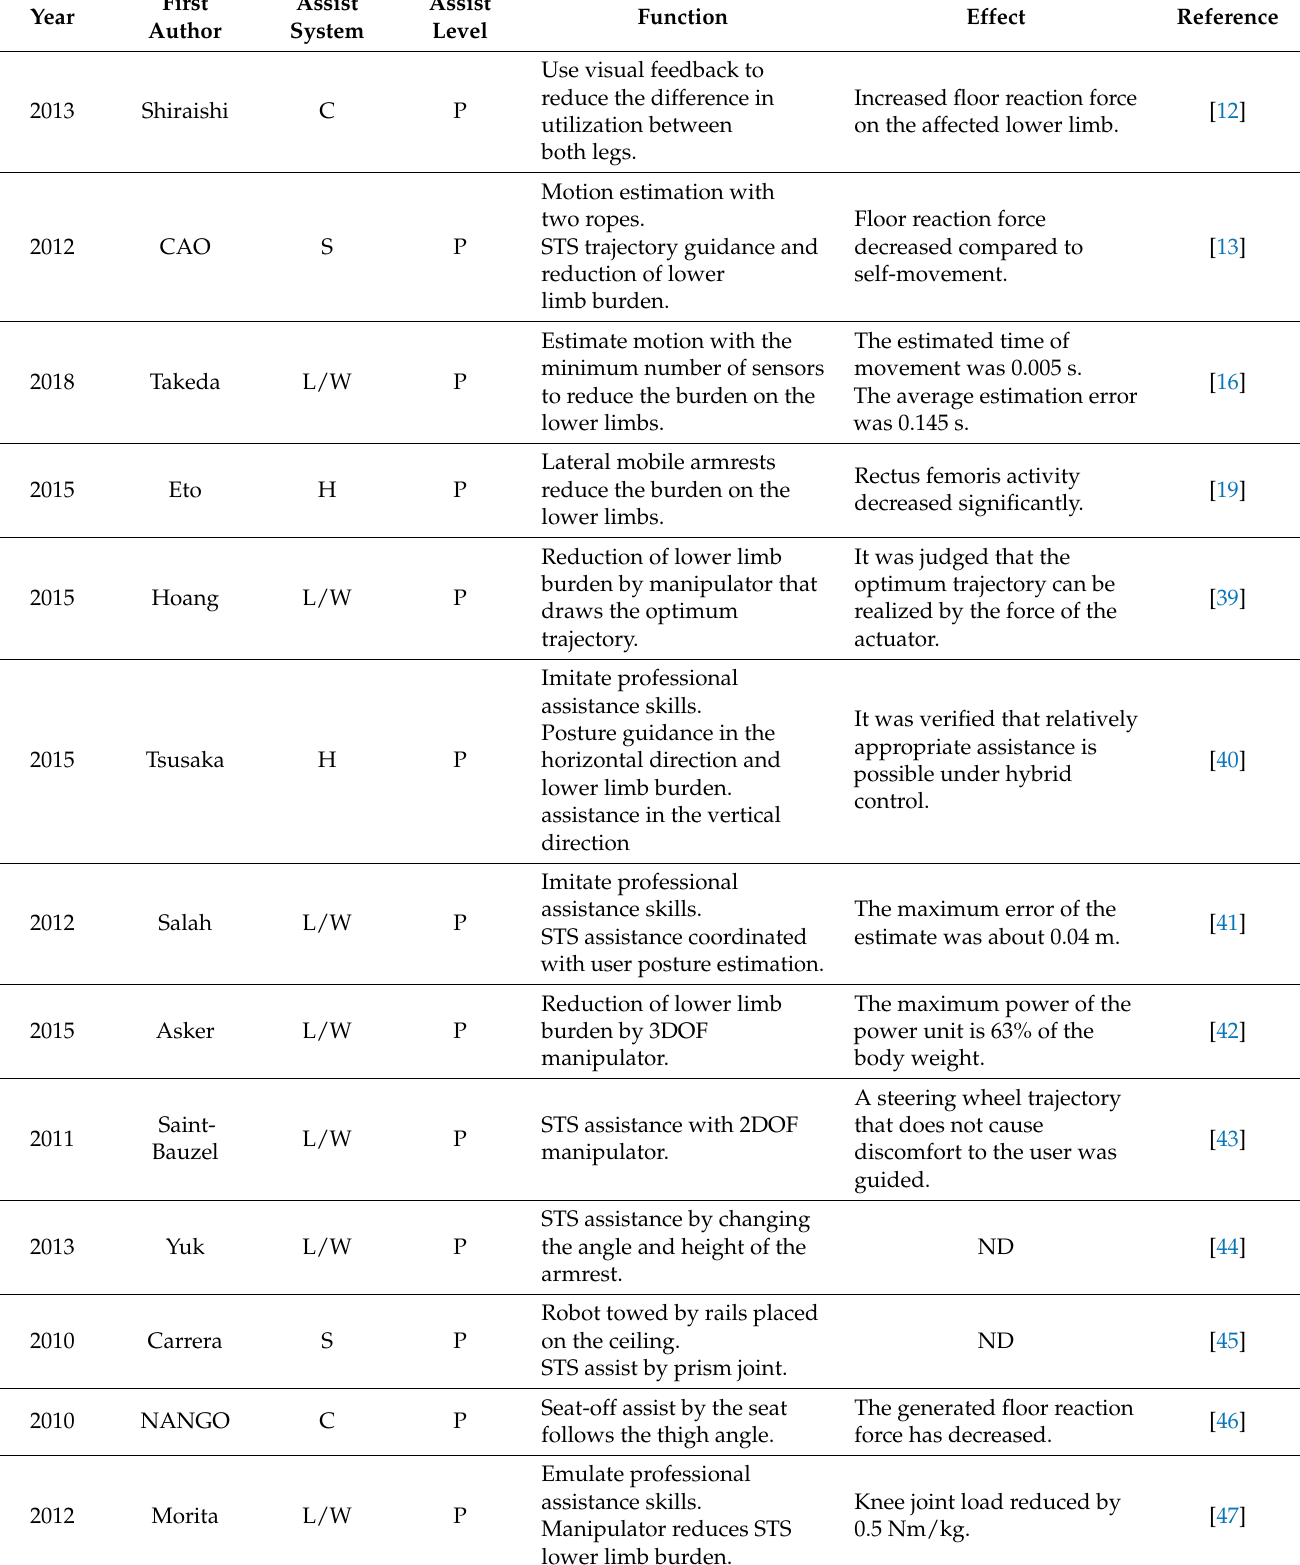
Table 2. Assist functions and effects (Non-wearable